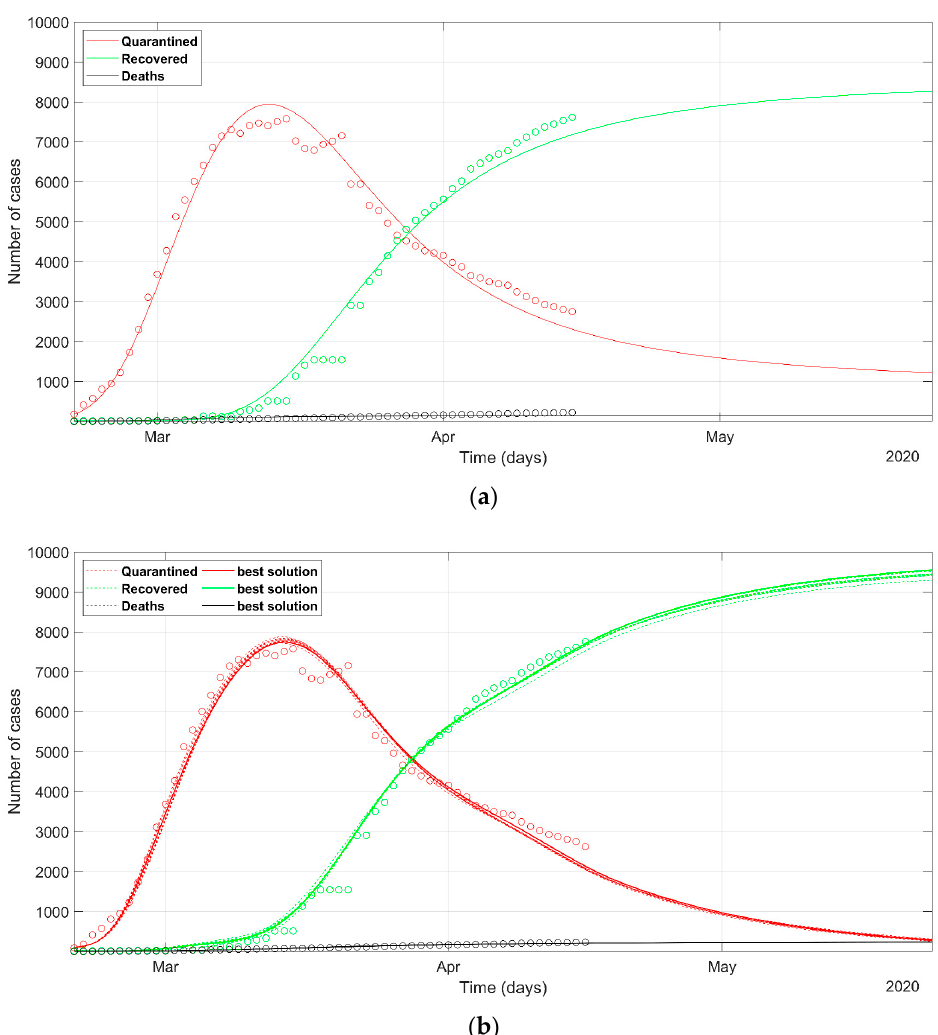
Figure 8. Observed data ( circles ) of quarantined ( red ), recovered ( green ), and deaths ( black ) for South Korea, updated on 15th April 2020. The continuous lines refer to the predicted evolution in 30 days according to the SEIR model solved with ( a ) deterministic approach, ( b ) stochastic approach. In ( b ) the solid line refers to the best PSO solution, the dashed lines refer to the most probable solutions (i.e., the solutions within 5% of the minimum NRMSE).